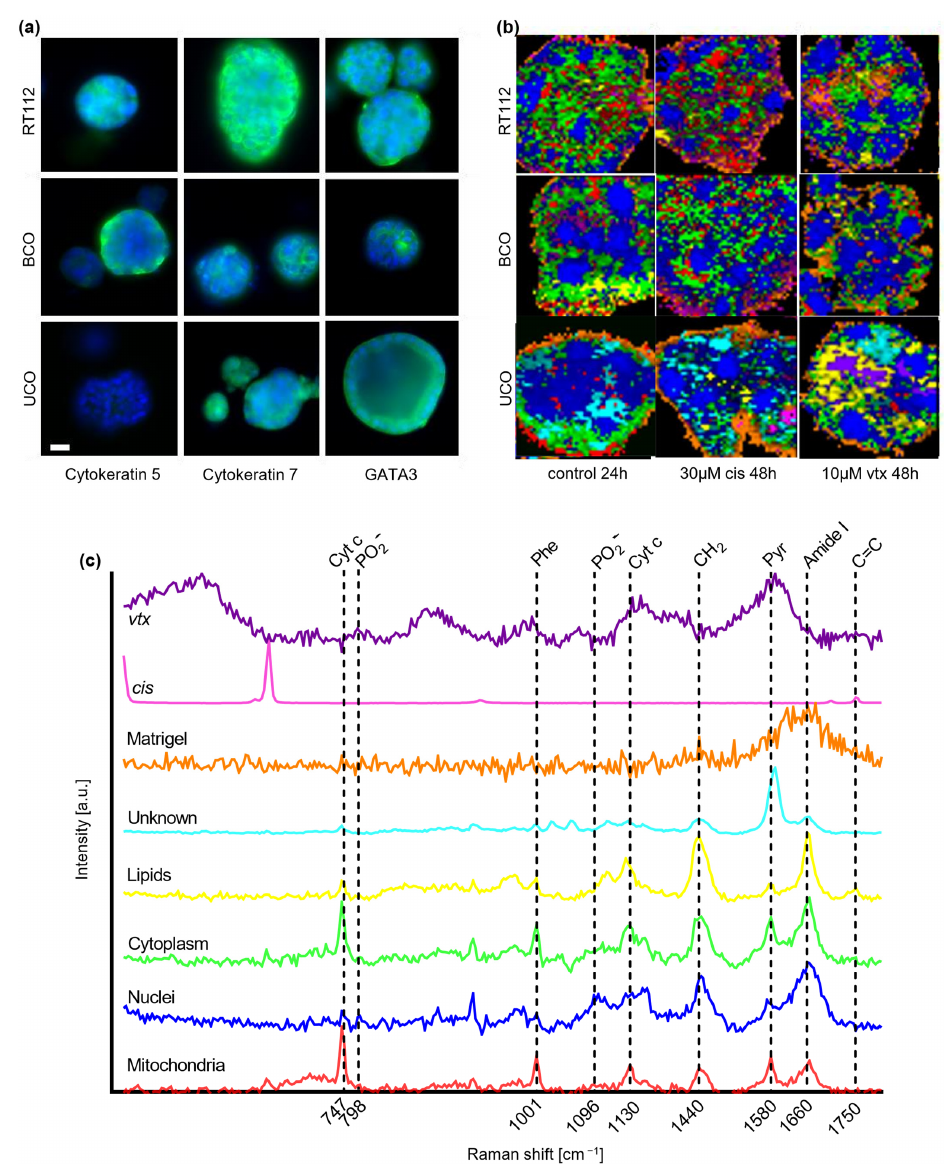
Figure 1. Immunofluorescence (IF) and Raman microspectroscopy (RMS) of different bladder cancer organoid models. ( a ) IF images of untreated RT112, BCO and UCO organoids stained for cytokeratin 5, cytokeratin 7 or GATA3 (green) and DAPI (blue). Scale bar: 25 µ m. ( b ) True component analysis (TCA) images of RT112, BCO and UCO organoids. Displayed is one representative scan of untreated and treated organoids (30 µ M cisplatin ( cis ) or 10 µ M venetoclax ( vtx )) for each organoid model. Scale bar: 20 µ m. ( c ) Relevant TCA spectra for the identified cellular